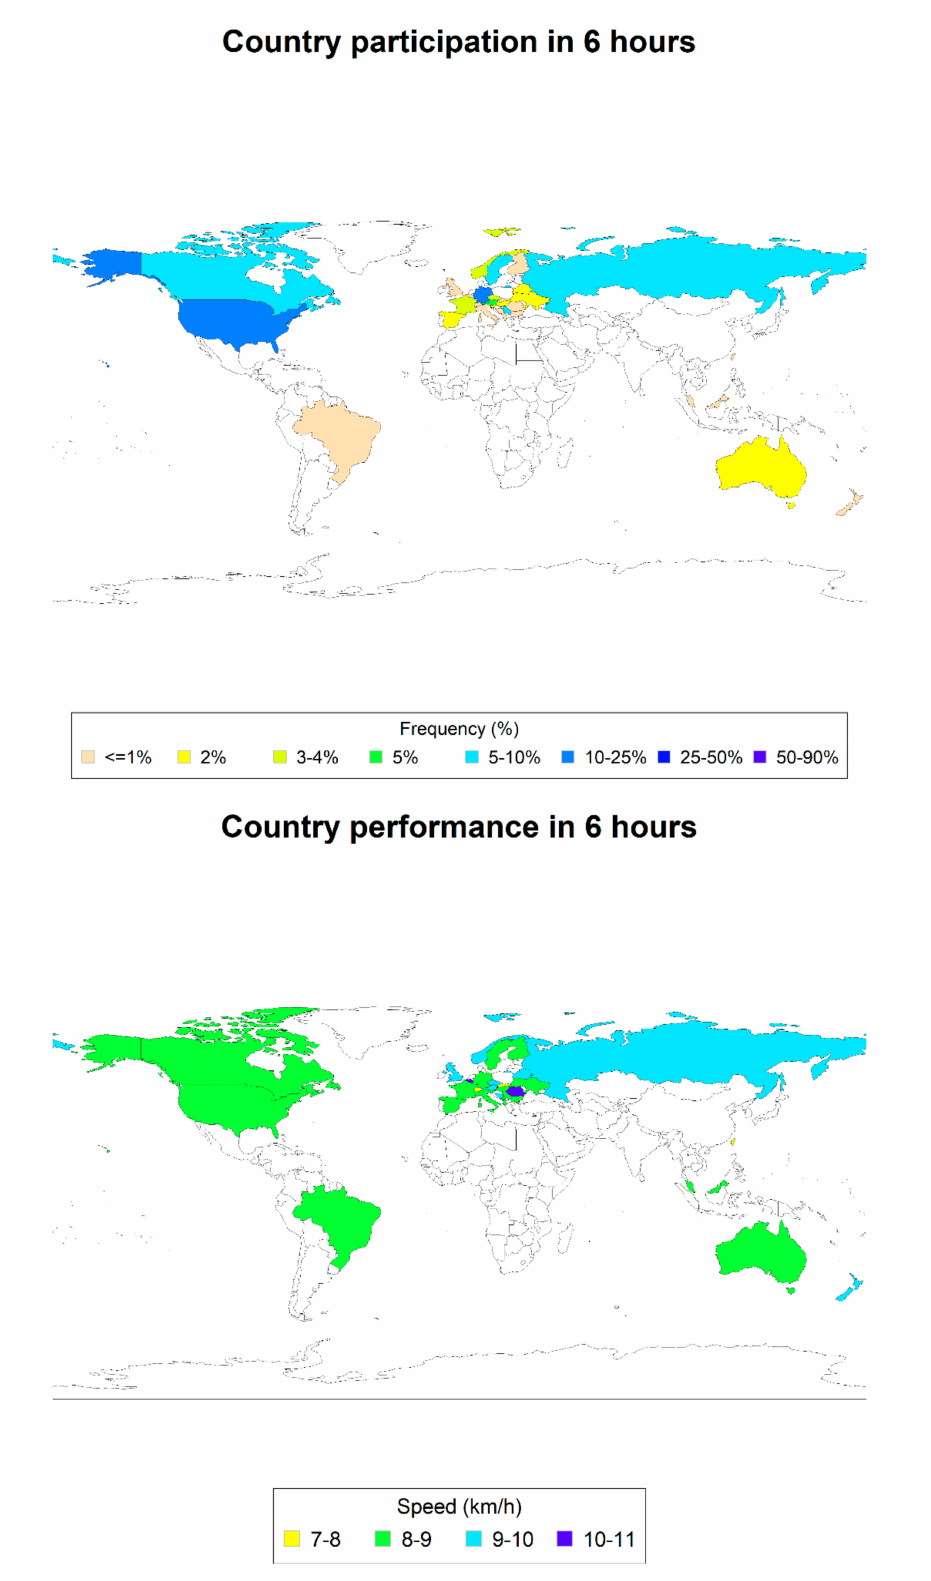
Figure 1. Participation (%) and average performance (km / h) by nationality in 6-h